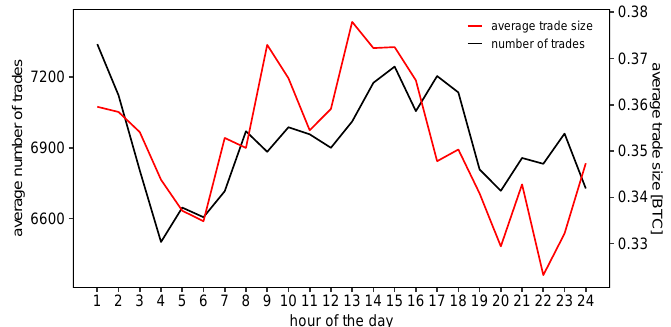
Figure 12. Intraday dynamics of trading activity. We plot the average hourly trade size and the average hourly number of trades as a function of the hour of the day in Hong Kong time.